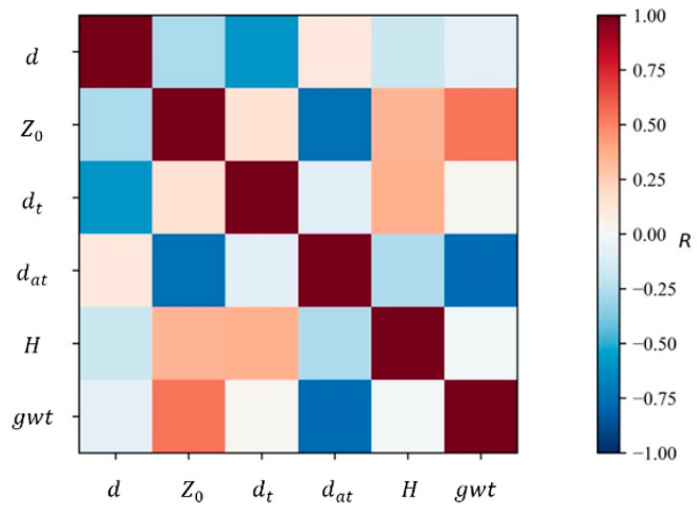
Figure 4. Variable correlation matrix.